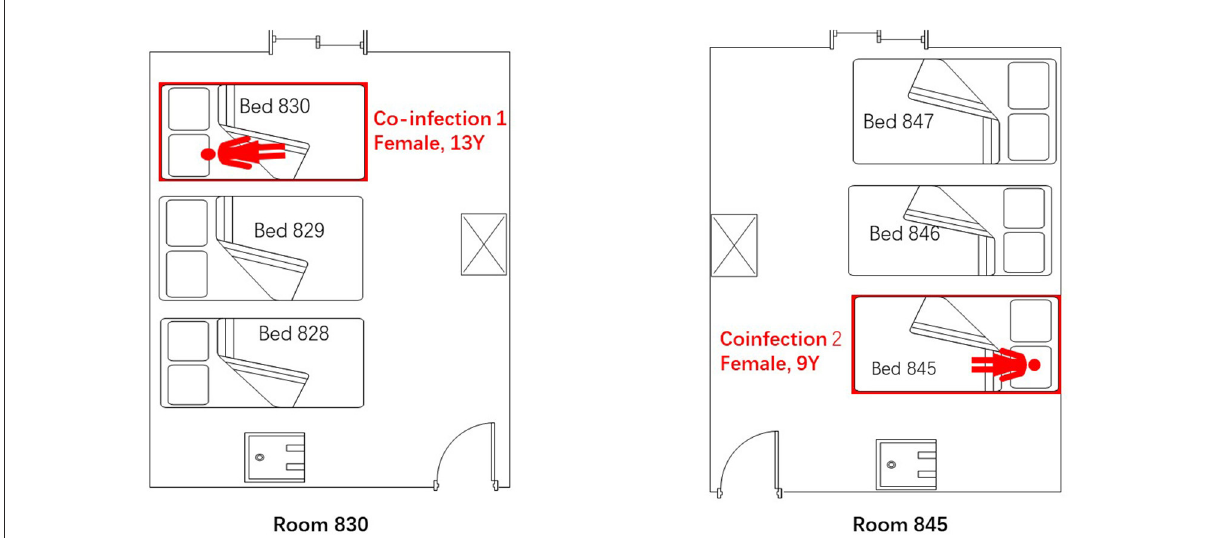
FIGURE2 Spatial distribution of the two admitted children who were coinfected with adenovirus and HCoV-229E in the pediatric ward of Lishui, Zhejiang Province, July–August 2019.